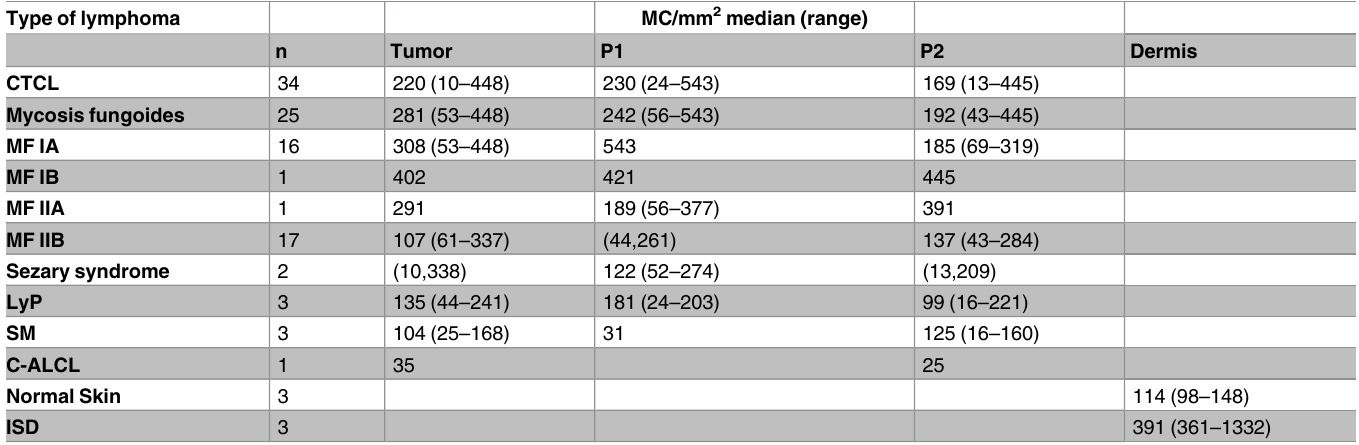
Table 2. Mast cell counts per mm 2 in different CTCL